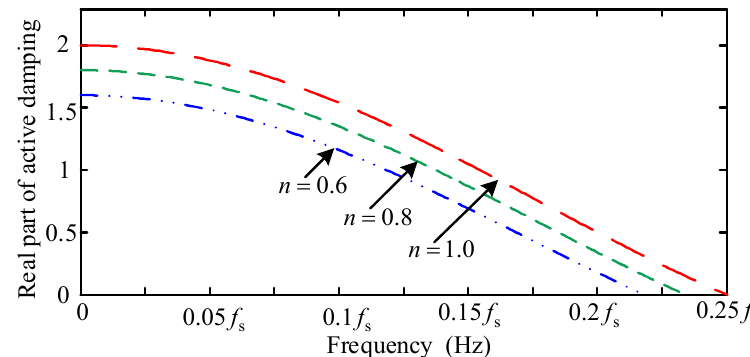
Figure 8. Range of active damping with different